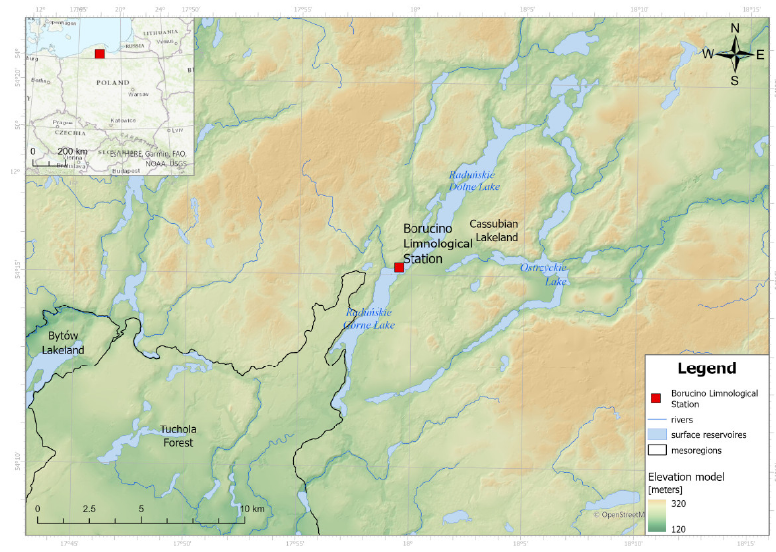
Figure 1. Location of Borucino Limnological